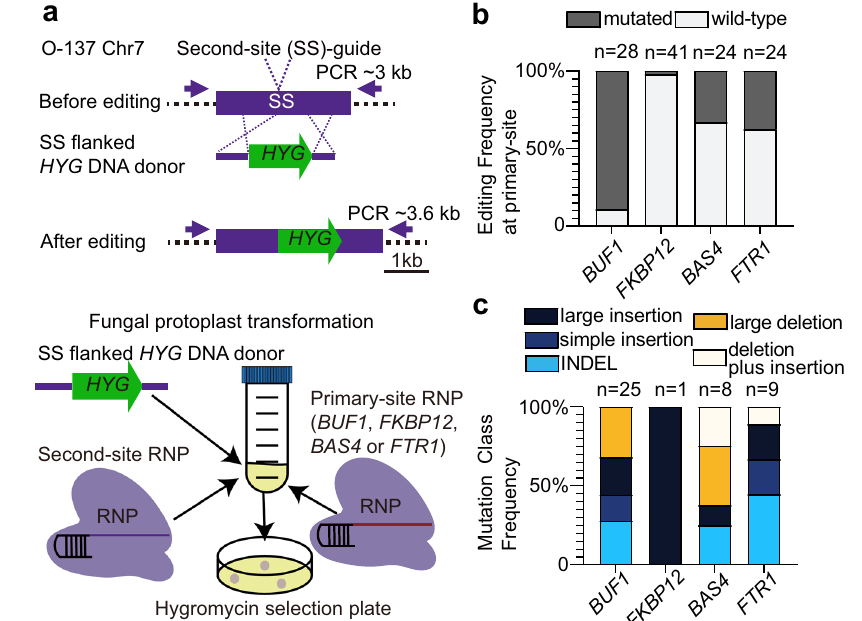
Fig. 6 | Distinct DSB repair pattens following donor insertion at a second integration site. a Schematic illustration of second-site (SS) insertion assay. The HYG coding sequence was directed to a second site through long homologous sequence located in a non-coding region on chromosome7 (chr7_O- 137:1,521,898 – 1,524,866). Fungal protoplasts were simultaneously transformed with two RNPs, one targeting the second-site and the other targeting the locus of interest. b The editing frequencies for the four tested loci following HYG selection (dark grey for mutant, light grey for wild-type) shown as the average outcome